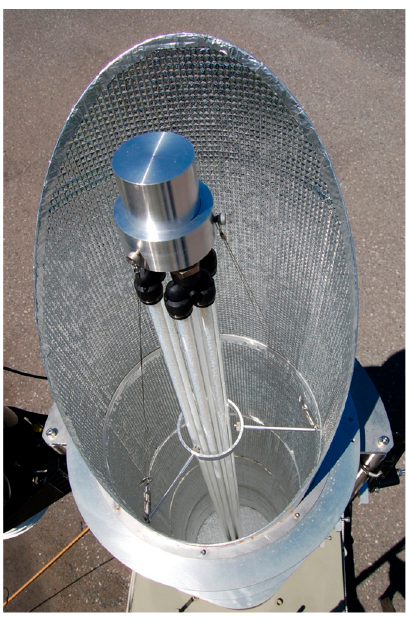
Figure 11. Top view of the HQC21-packed glass tube